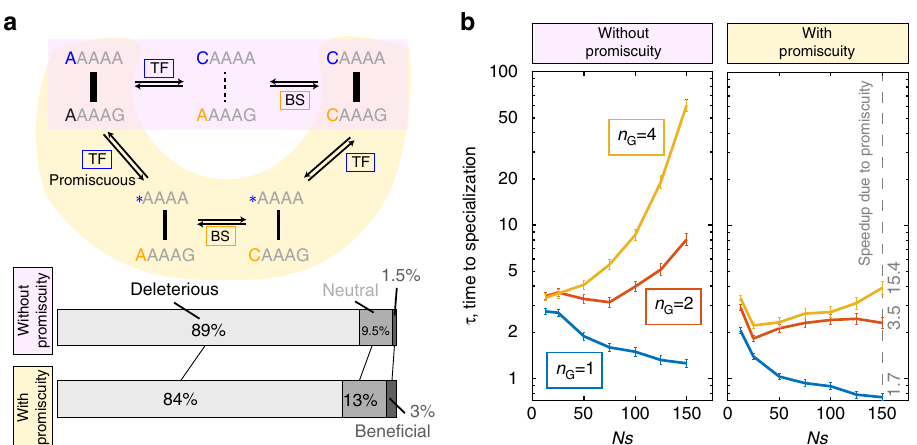
Fig. 5 Promiscuity-promoting mutations speed up specialization with multiple regulated genes per TF. a In the absence of promiscuity-promoting mutations, a compensatory series of point mutations in the TF ’ s consensus ( upper sequence ) and its binding site ( lower sequence ) is needed to maintain TF – BS speci fi city (top; light red ). Alternatively, in the presence of promiscuity-promoting mutations in the TF consensus, a position in the TF ’ s recognition sequence (marked by a star ) can lose and later regain sequence speci fi city ( middle ; light yellow ). Promiscuity decreases the fraction of deleterious mutations along typical pathways to specialization ( bottom , computed using baseline parameters). b Time to specialization as a function of selection strength, Ns , without ( left ) and with ( right ) promiscuity promoting mutations in the TF, for different numbers of regulated genes per TF, n G ( color ). Numbers in gray ( right ) denote the speed-up